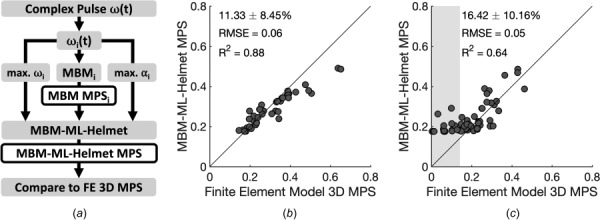
ML-assisted MBM performance after training on results from helmet impact tests. (a) Flow diagram for evaluating the ML model trained on helmet impact tests (MBM-ML-helmet), where i represents each planar direction. (b) MBM-ML-helmet model performance on the testing set of helmet impact acceleration inputs. (c) MBM-ML-helmet model performance on independent human impact reconstructions. The shaded region lies outside the lower bound MPS of the training set for the ML model, creating an MPS prediction floor. Error metrics only include points within the bounds of the training set.